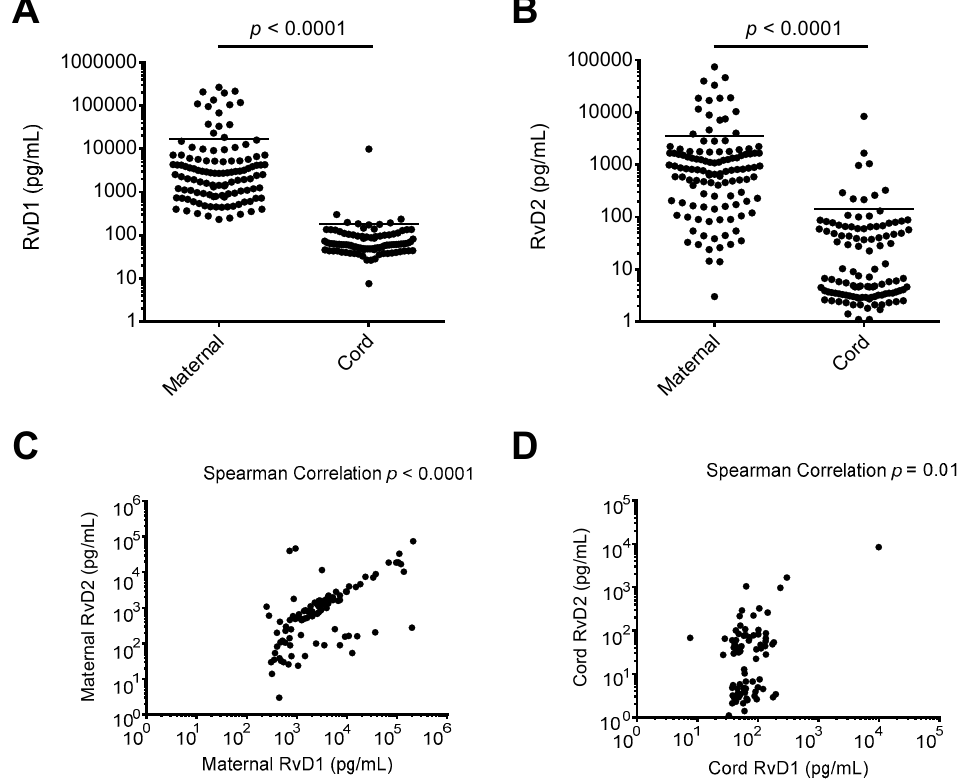
Figure 1. Resolvin D1 (RvD1) and Resolvin D2 (RvD2) levels in maternal and cord blood plasma. Enzyme immunoassays were performed on maternal and cord blood plasma samples collected upon admission for delivery and at birth, respectively. ( A ) RvD1 levels in maternal and cord blood plasma; ( B ) RvD2 levels in maternal and cord blood plasma; ( C ) comparison of maternal RvD1 and RvD2 plasma levels; ( D ) comparison of cord RvD1 and RvD2 plasma levels.